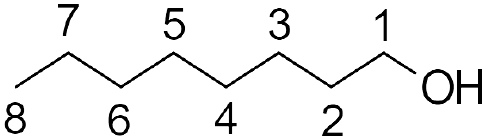
Figure 1. n-octanol molecule with carbon atoms numbering